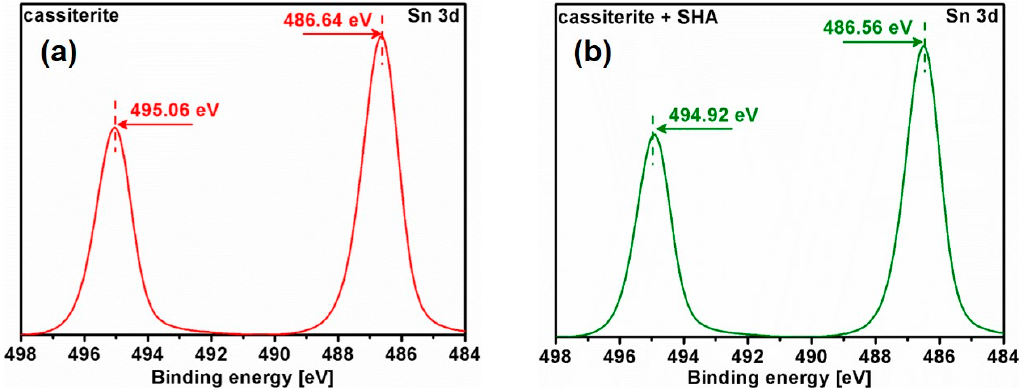
Figure 9. Sn 3d XPS spectra recorded from the surfaces of cassiterite in the absence ( a ) and presence ( b ) of